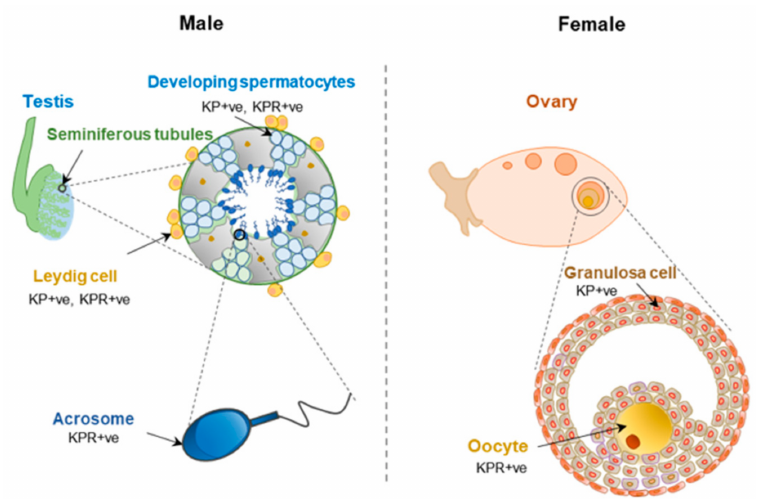
Figure 9. Extrahypothalamic kisspeptin and kisspeptin receptor in gonads. Kisspeptins (KPs) and KP receptor (KPR) are expressed in the sperm. KPs are not detected in spermatids but KPR is expressed in acrosomal region of spermatids and mature spermatozoa. KPs and KPR are also detected in the ovaries. While KPs are predominantly expressed by the granulosa cells, KPR is expressed in the oocytes. KPR+ve, stands for kisspeptin receptor